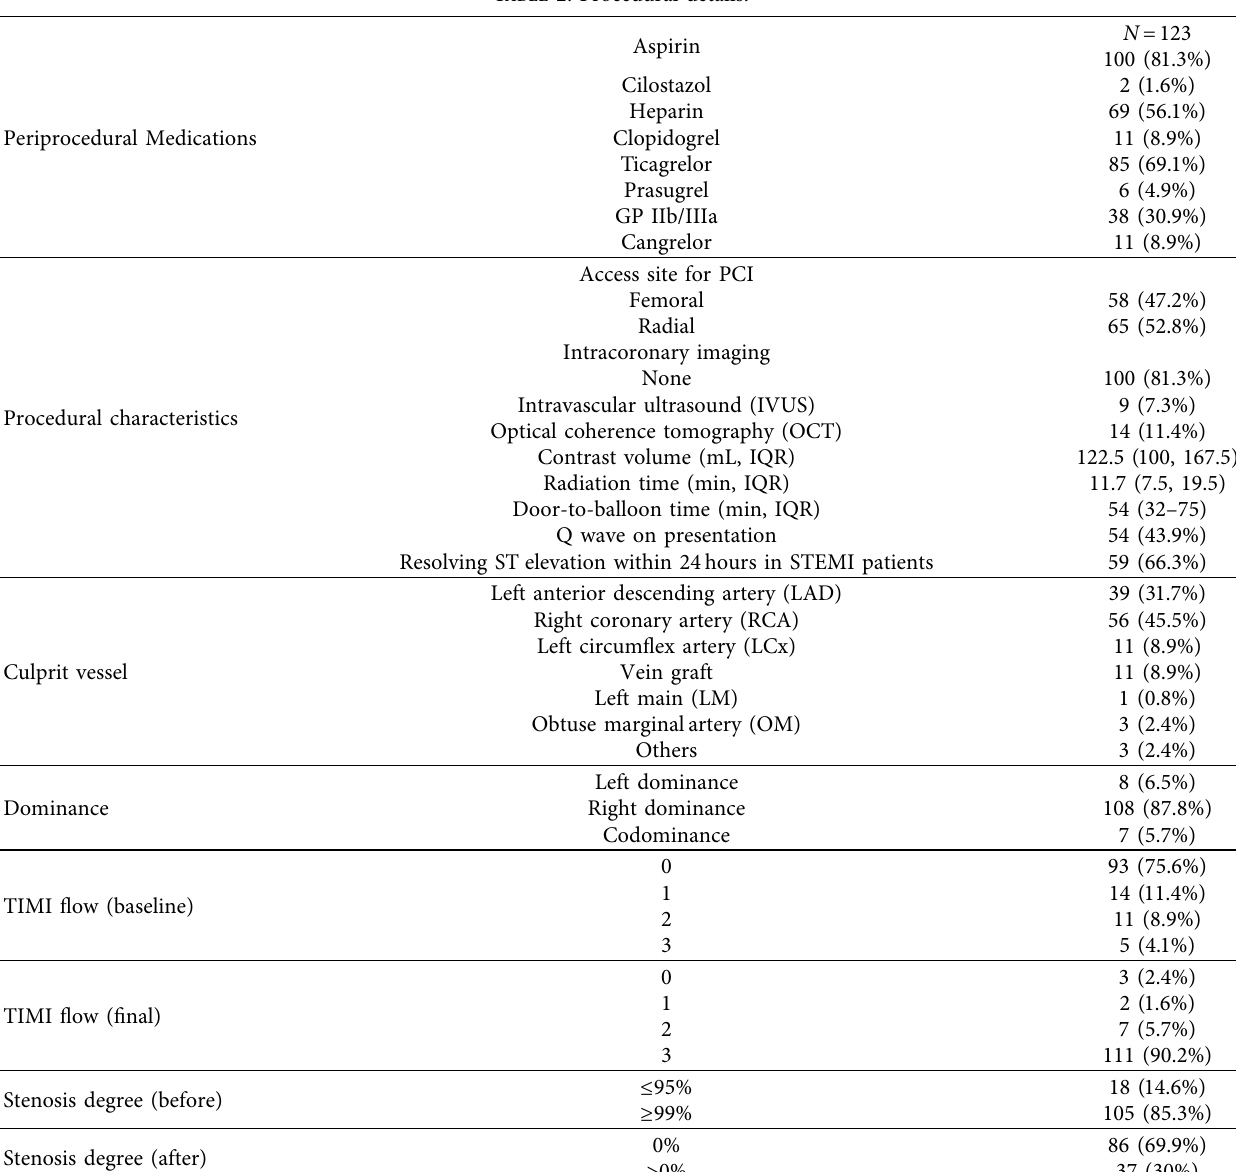
Figure 3: (A) TIMI flow before Penumbra (grade). (B) TIMI flow after Penumbra (grade). TIMI, thrombolysis in myocardial Table 2: Procedural details.